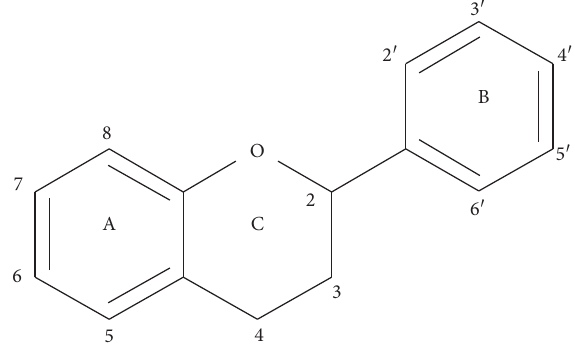
Figure 1: Basic flavonoid